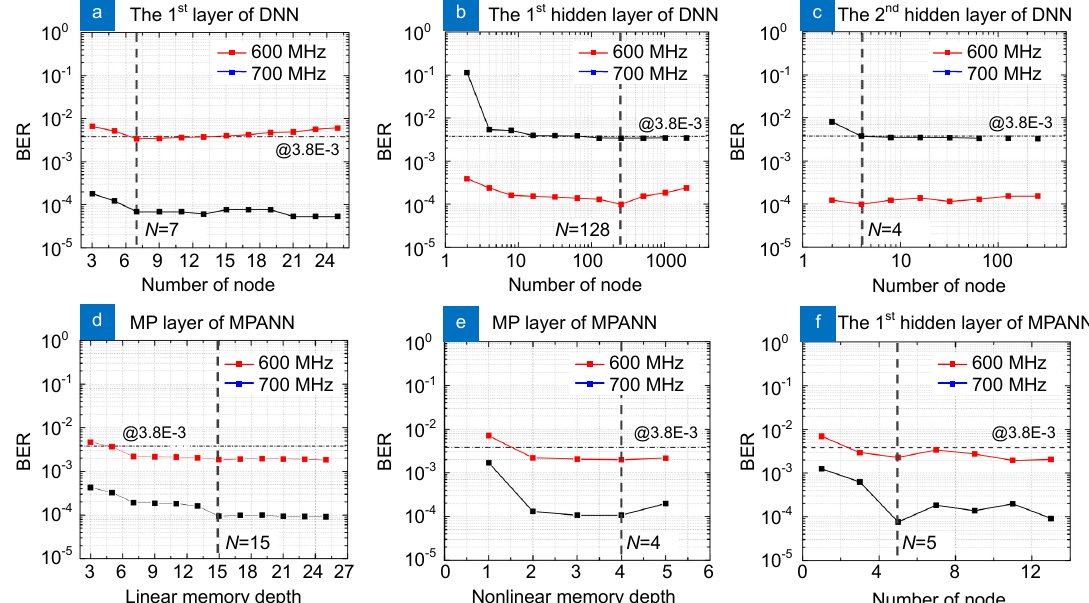
Fig. 6 | BER performance when varying ( a ) the number of nodes of the first layer of DNN, ( b ) the number of nodes of the first hidden layer of DNN, ( c ) the number of nodes of the second layer of DNN, ( d ) the linear memory depth of MPANN, ( e ) the nonlinear memory depth of MPANN, and ( f ) the number of nodes of the first hidden layer of MPANN when the bandwidth of CAP-16-QAM is 600 MHz and 700 MHz. N : The optimal and utilized number of nodes.